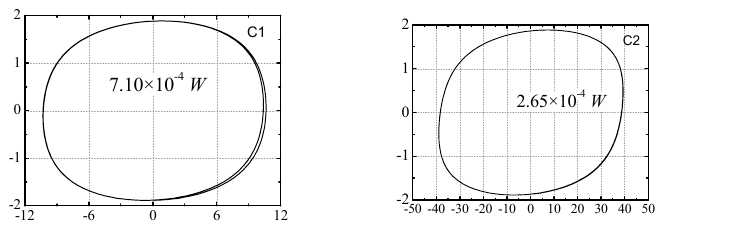
Figure 23. Phase diagrams of F y − V y and M z − ω z at nine working points.